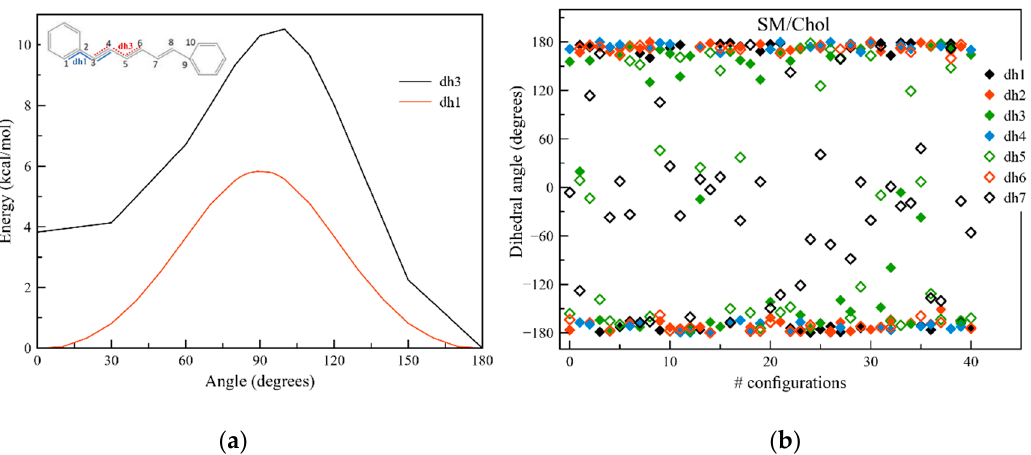
Figure 1. ( a )Dihedralangleenergybarriersfordh1(1-2-3-4)anddh3(3-4-5-6)ofDPH(diphenylhexatriene). Figure 1. ( a ) Dihedral angle energy barriers for dh1 (1-2-3-4) and dh3 (3-4-5-6) of DPH All values have been obtained in vacuum, at the B3LYP / cc-pVDZ level of theory. The inset shows the ttt (diphenylhexatriene). All values have been obtained in vacuum, at the B3LYP/cc-pVDZ level of isomer of DPH; the numbers refer to the atoms used for the dihedral analysis; ( b ) Values of the 7 dihedral theory. The inset shows the ttt isomer of DPH; the numbers refer to the atoms used for the dihedral angles of DPH observed in all 40 snapshots selected over the trajectories for SM / Chol (Lo). dh7 is defined analysis; ( b ) Values of the 7 dihedral angles of DPH observed in all 40 snapshots selected over the with respect to the opposite side of the phenyl ring compared to trajectories for SM/Chol (Lo). dh7 is defined with respect to the opposite side of the phenyl ring compared to dh1.